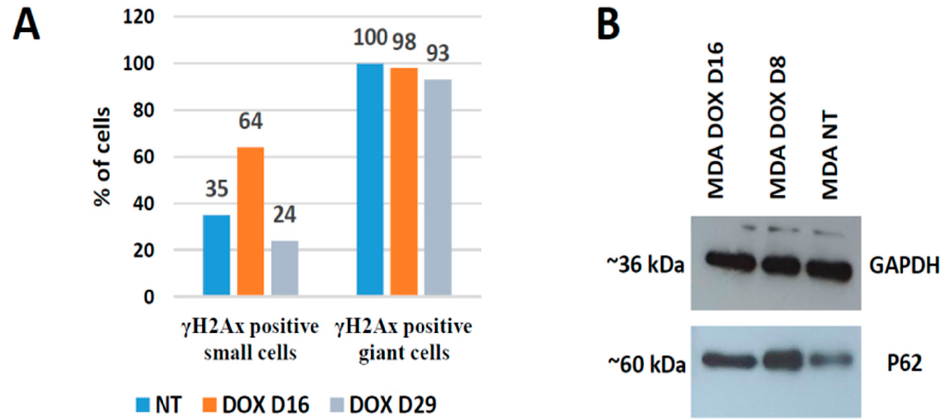
Figure 11. DNA damage, repair, and autophagy in MDA-MB-231 cells after DOX treatment. ( A ) Microscopic counts of gamma-H2AX-positive cells showing recovery after DOX of small cells without DNA DSBs, while late polyploidy giant cells remain with DNA breaks. ( B ) Western blot analysis of autophagy marker p62 expression in NT control cells and after DOX treatment. The GAPDH antibody is used as a loading control at the same time points.